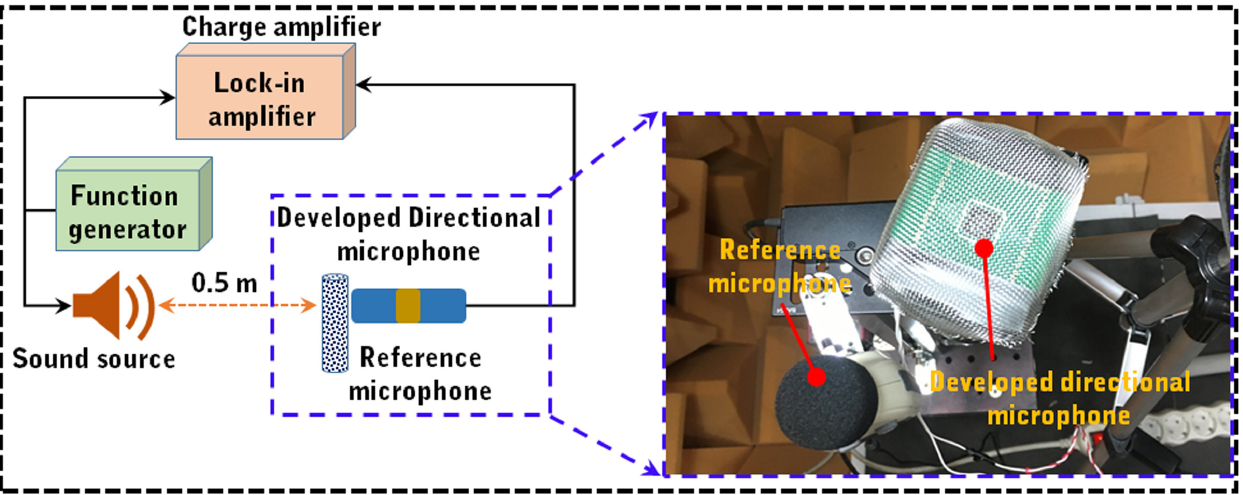
Figure 8. Experimental setup in an anechoic chamber with a zoomed-in real view of the microphone